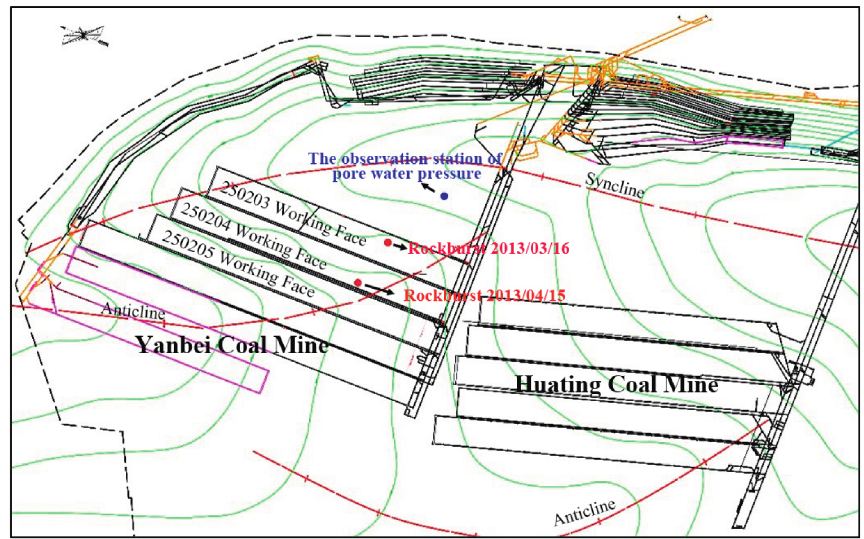
Figure 2: Project overview, location of observation station, and rockburst